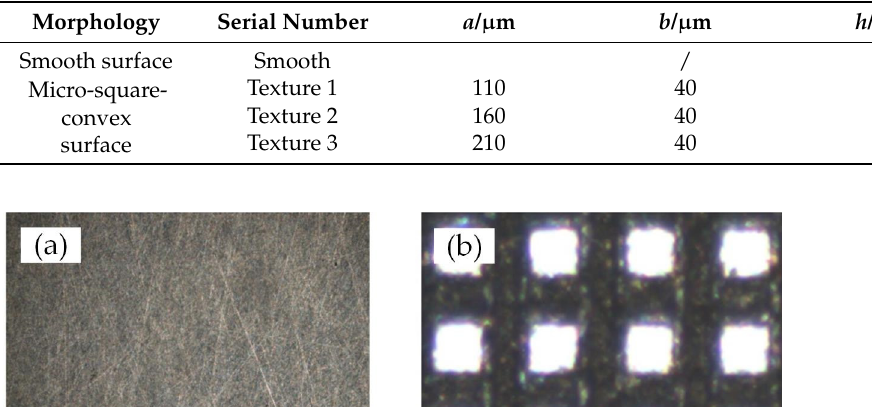
Table 1. Detailed morphological parameters of the micro-square-convex surfaces.